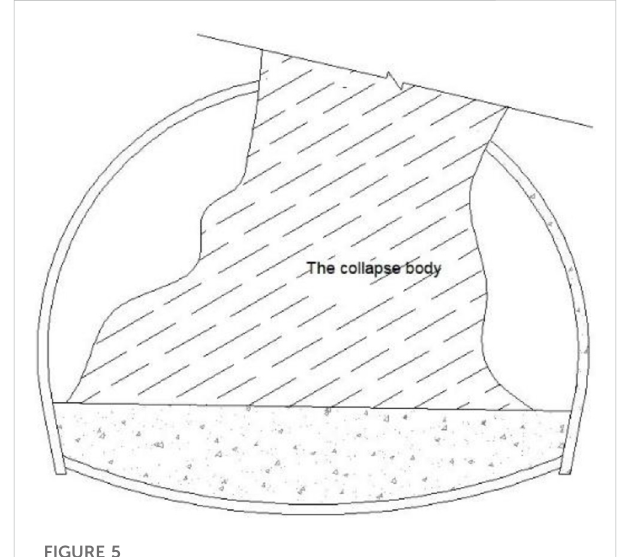
FIGURE 5 Collapse failure of the initial support (Schematic diagram).